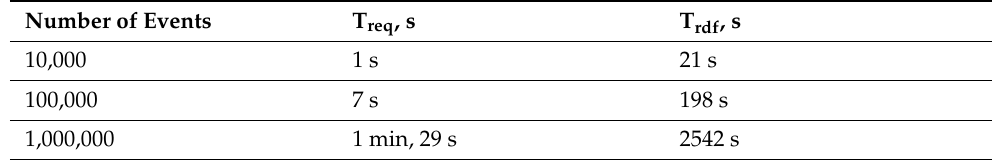
Table 3. System modeling results NoN = 100,000.